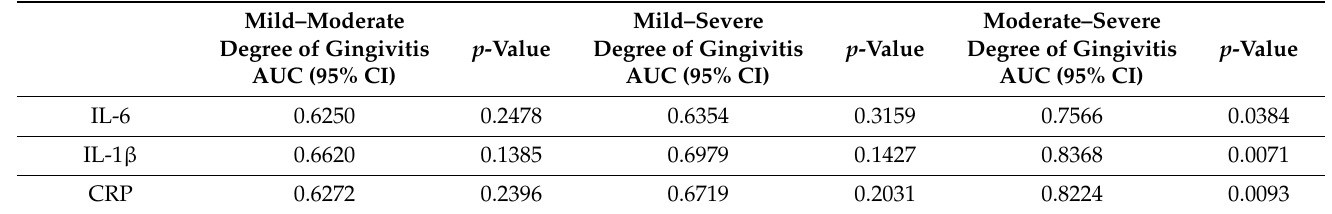
Table 2. ROC logistic regression analysis of salivary IL-6, IL-1 β , and CRP levels comparing the groups of children with different degrees of plaque-induced gingivitis.